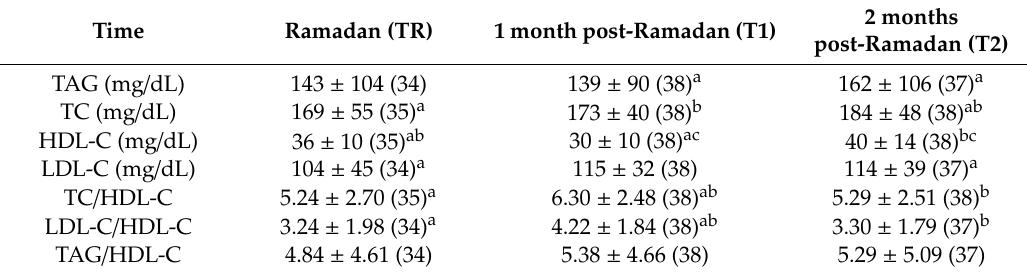
Table 3. Plasma lipid